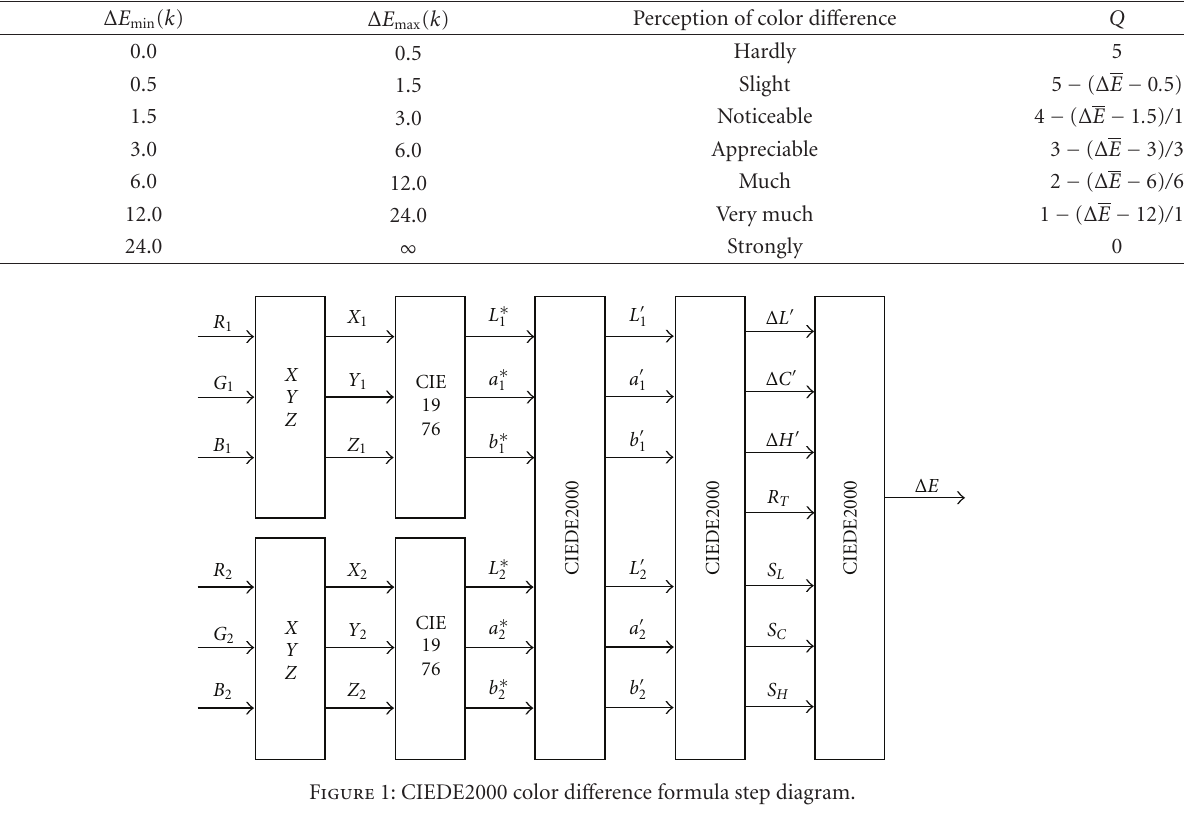
Table 1: Subjective assessment metric based on CIEDE2000 Color di ff erence.